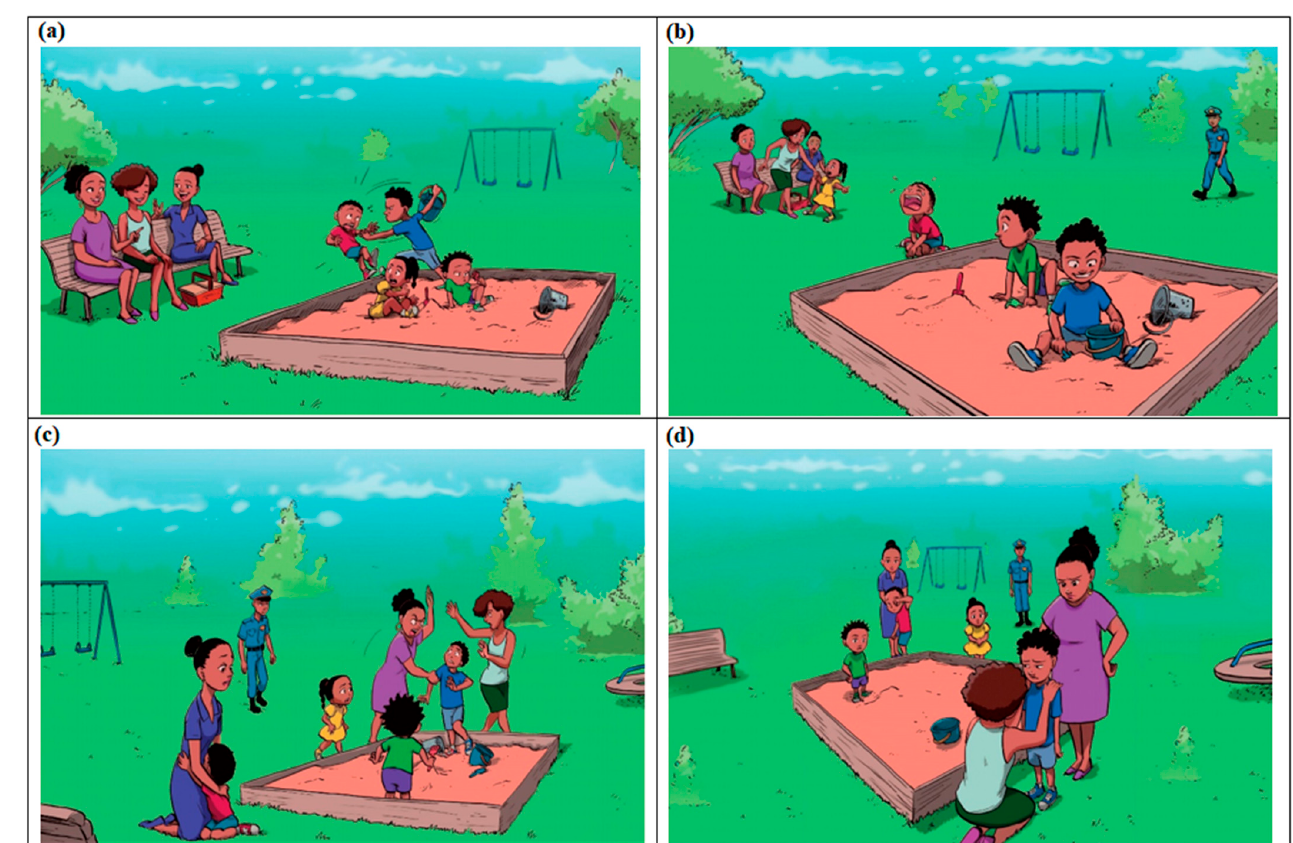
Figure 1. Four sample images from the book, “A Day at the Park”. ( a ) Child pushes another child [Action 1] and takes the other child’s toy without asking [Action 2]. ( b ) Boy has taken other child’s toy [Action 2]; child who was pushed starts crying and girl asks her mother for help [Prosocial Action 4]. ( c ) Mother attempts to apply physical punishment to the child who had taken the toy [Action 3]. ( d ) Mother talks to child as strategy to resolve conflict [Prosocial action